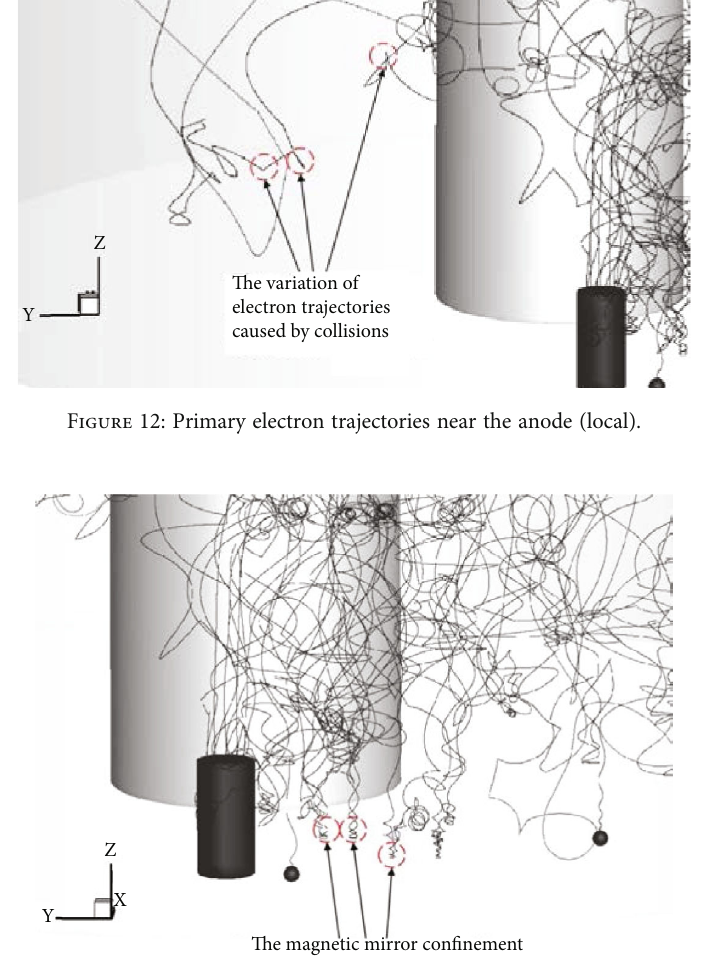
Figure 13: Primary electron trajectories near the cathode (local).